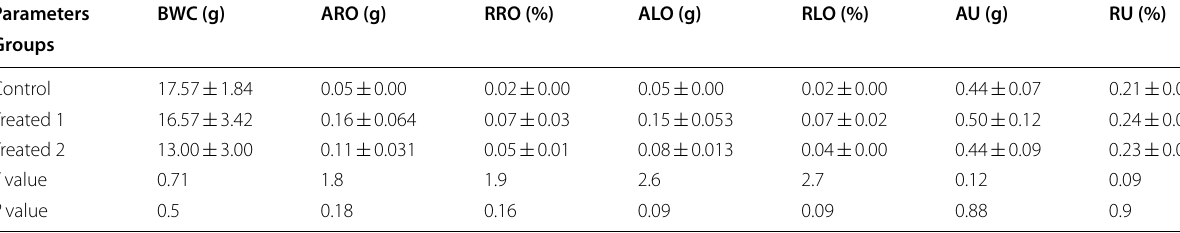
The data expressed as mean standard error of the mean. N 7 ± = BWC, body weight change; ARO, absolute right ovary; RRO, relative right ovary; ALO, absolute left ovary; RLO, relative left ovary; AU, absolute uterus; RU, relative uterus